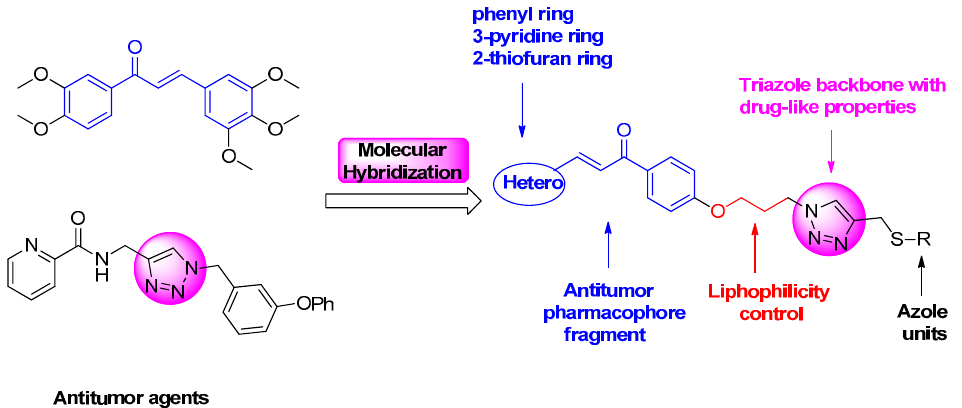
Figure 3. Illustration of the design strategy for target compounds.